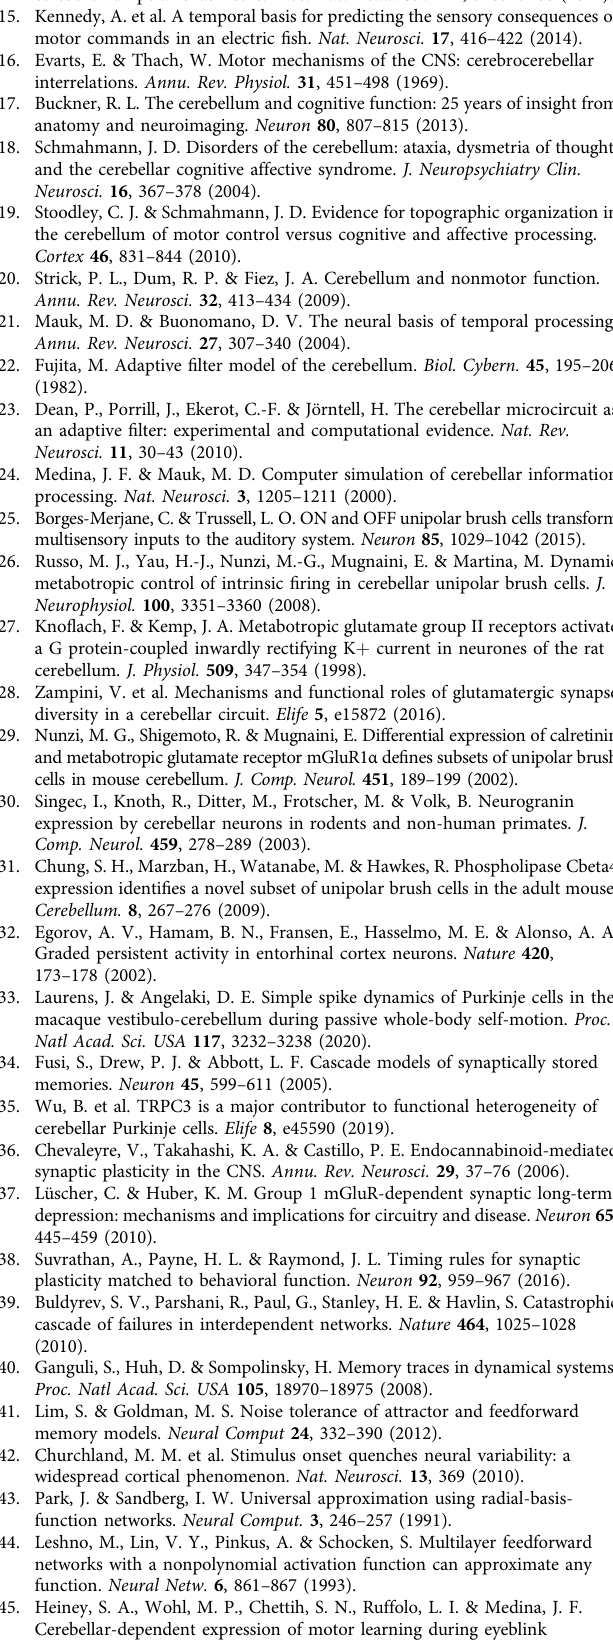
values vs. cell ID in Fig. 6h. Kolmogorov-Smirnov test was used for testing whether the distribution of peak time followed a uniform distribution on a logarithmic timescale. The population response amplitude was de fi ned as the L 2 -norm of the population activity vector, which each dimension being the instantaneous fi ring rate of one UBC over time. For ease of interpretation and to control for the ffiffiffiffi p expected N increase in population amplitude as a function of N, the number of measured neurons, the population amplitude was normalized by 1 ffiffiffi